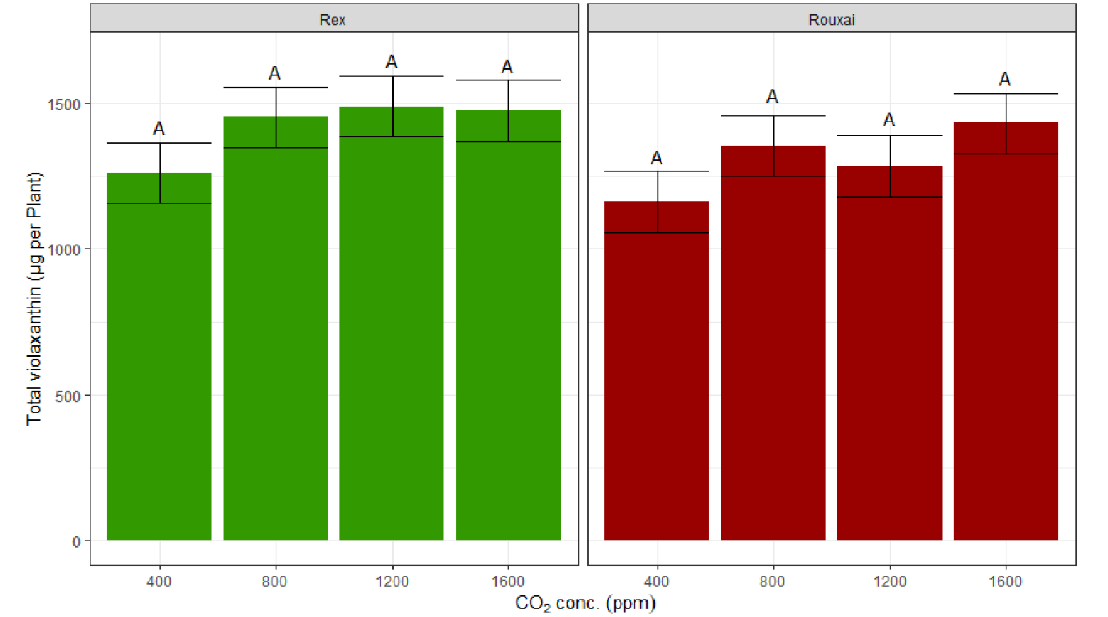
Figure 7. Total violaxanthin content within each lettuce plant for ‘Rex’ and ‘Rouxai’ after 21 days increasing concentrations of CO 2 . Data represent estimated marginal means and standard error as calculated by five plants across four replicates in a complete randomized block design. Letters represent mean separation comparison using Tukey’s Honestly Significant Difference (alpha = 0.05).